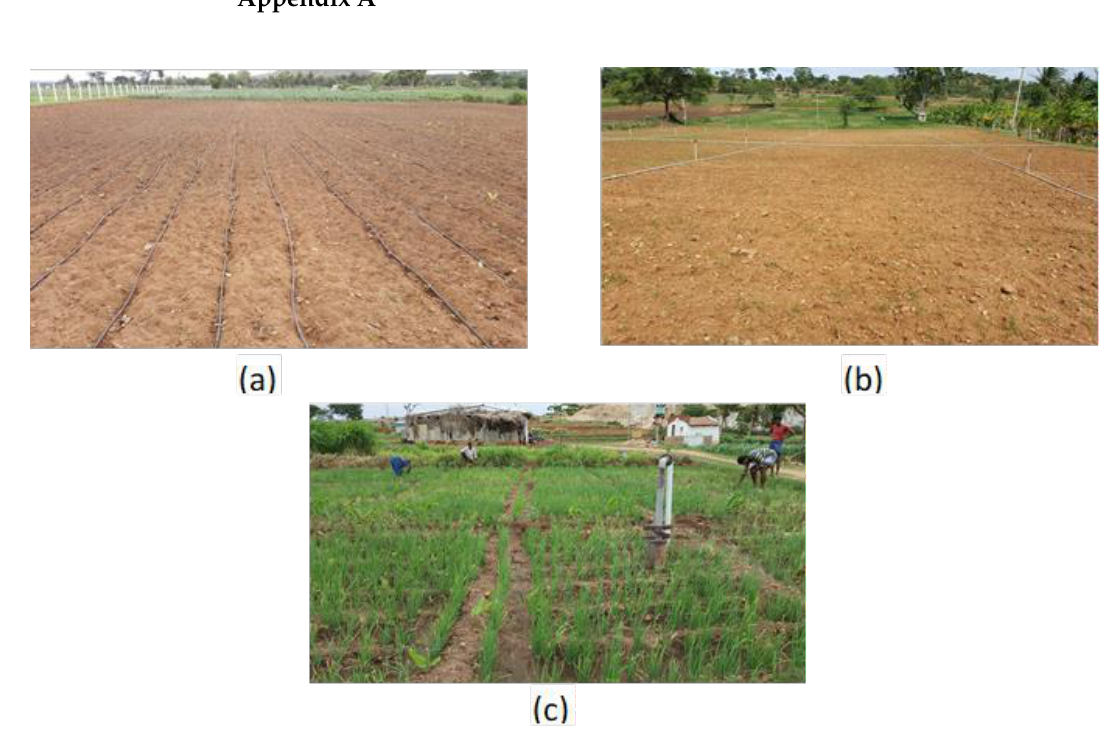
Figure A1. Irrigation practices in the Berambadi watershed: ( a ) drip irrigation, ( b ) sprinkler irrigation, ( c ) flood irrigation.